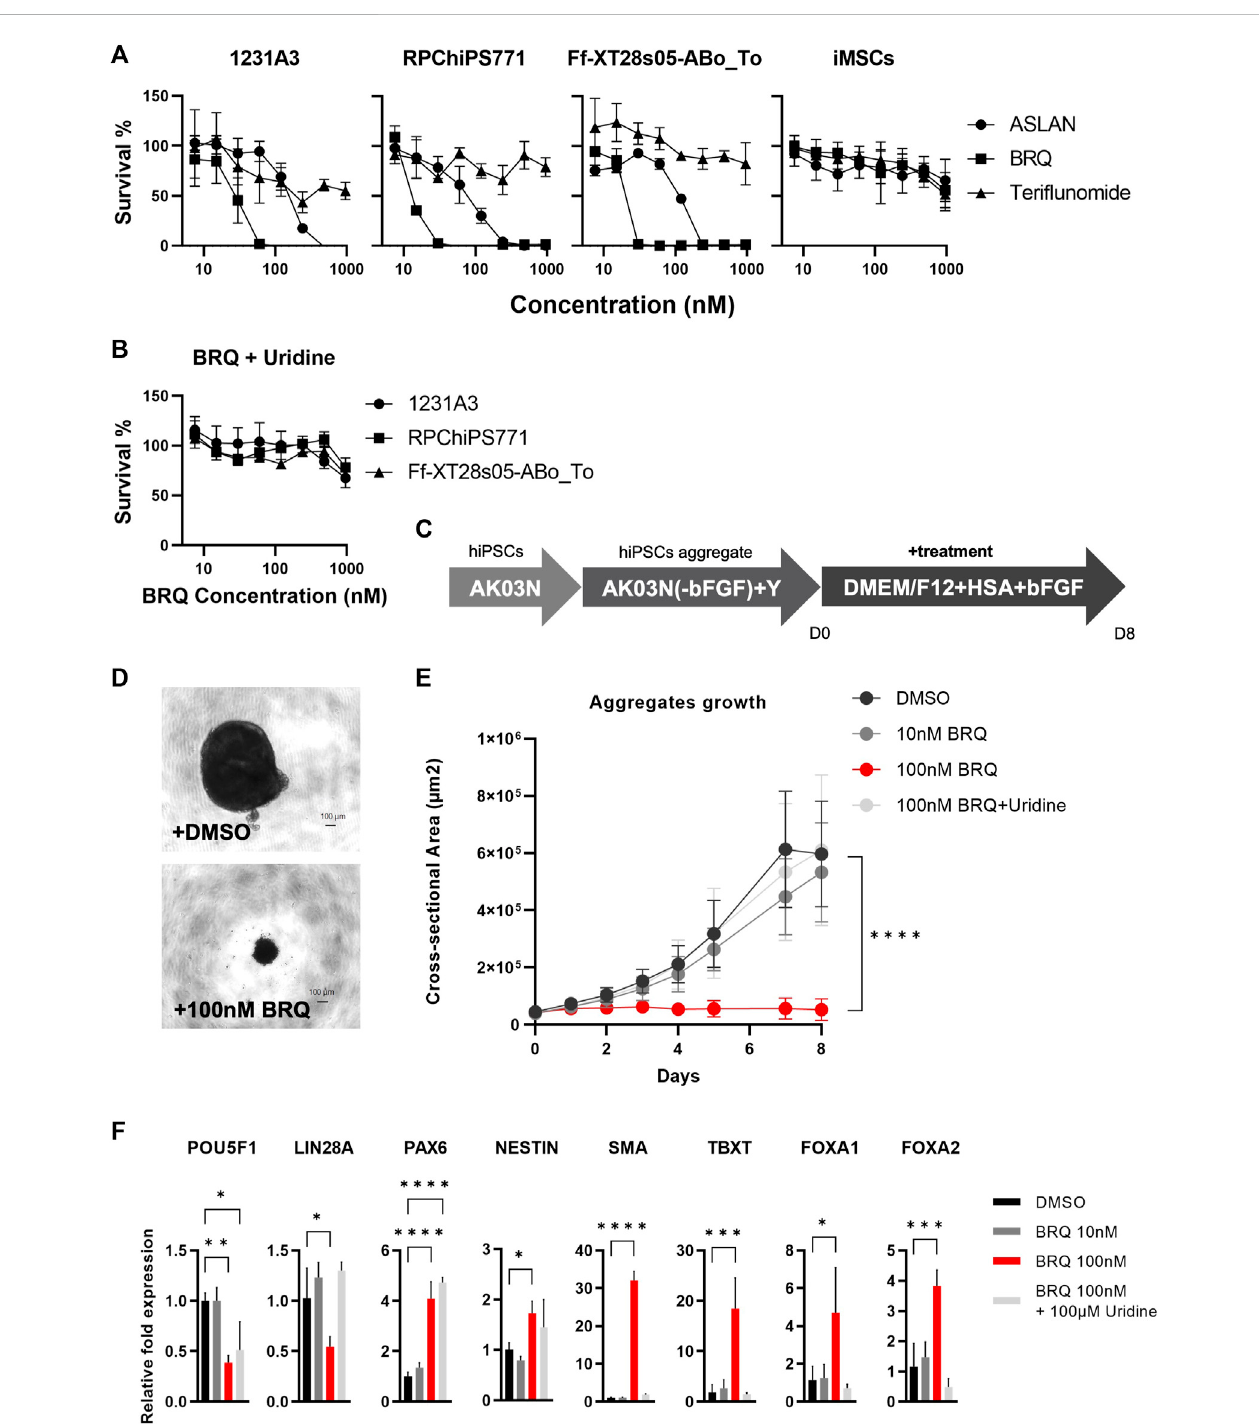
FIGURE 1 Vulnerability of hiPSCs to DHODH inhibition (A) Survival measurement using water-soluble formazan dye after the treatment with DHODH inhibitors, Teri fl unomide (Triangle), ASLAN (Circle), and Brequinar (Square) for 7 days on 1231A3, RPChiPS771, Ff-XT28s05-ABo_To hiPSCs lines and iMSCs (From left to right). (B) Rescued survival of 1231A3 (Circle), RPChiPS771 (Square), and Ff-XT28s05-ABo_To (Triangle) BRQ-treated hiPSCs lines by 100 µM Uridine supplementation. Data plotted as meanwith errorbar S.D,minimum oftriplicates perhiPSCs lineand triplicates ofthree biological repeatsoftheiMSCs. (C) Schematic representation of iPS cell aggregates formation, hiPSCs were collected in single cell suspension then cultured in ultra-low attachment U-bottom96-wellplatesinStemFitBasic03inthepresenceofROCKinhibitor(Y)for2 – 3 daysuntilaggregateswithclearedgesareformed.Mediumthenwas replaced with DMEM/F-12 supplemented with 0.1% HSA and 10 ng bFGF and (D) phase contrast images were taken, then the (E) area of each aggregate was measured, dots represent mean and error bar is S. D, n = 6, biological replicates. (F) Relative mRNA expression of pluripotency markers (POU5F1 and LIN28), ectodermal markers (PAX6 and NESTIN), mesodermal markers (SMA and TBXT), and endodermal markers (FOXA1 and FOXA2), mRNA of minimum 4 aggregates were extracted per sample after 3 days of treatment then expression was detected by RT-qPCR, DMSO (Black), 10 nM BRQ (Dark gray), 100 nM BRQ (Red) and 100 nM BRQ with 100 µM Uridine (Light gray). Bar: mean, Error bar: S. D, n = 3, biological